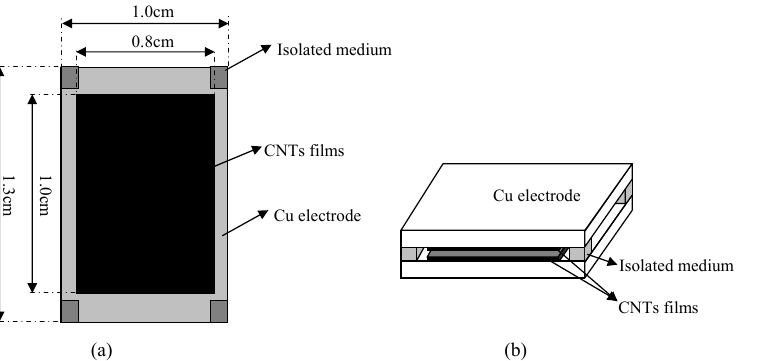
Figure 10. Detailed structure feature ( a ) and schematic diagram ( b ) of a capacitive humidity sensor [52].